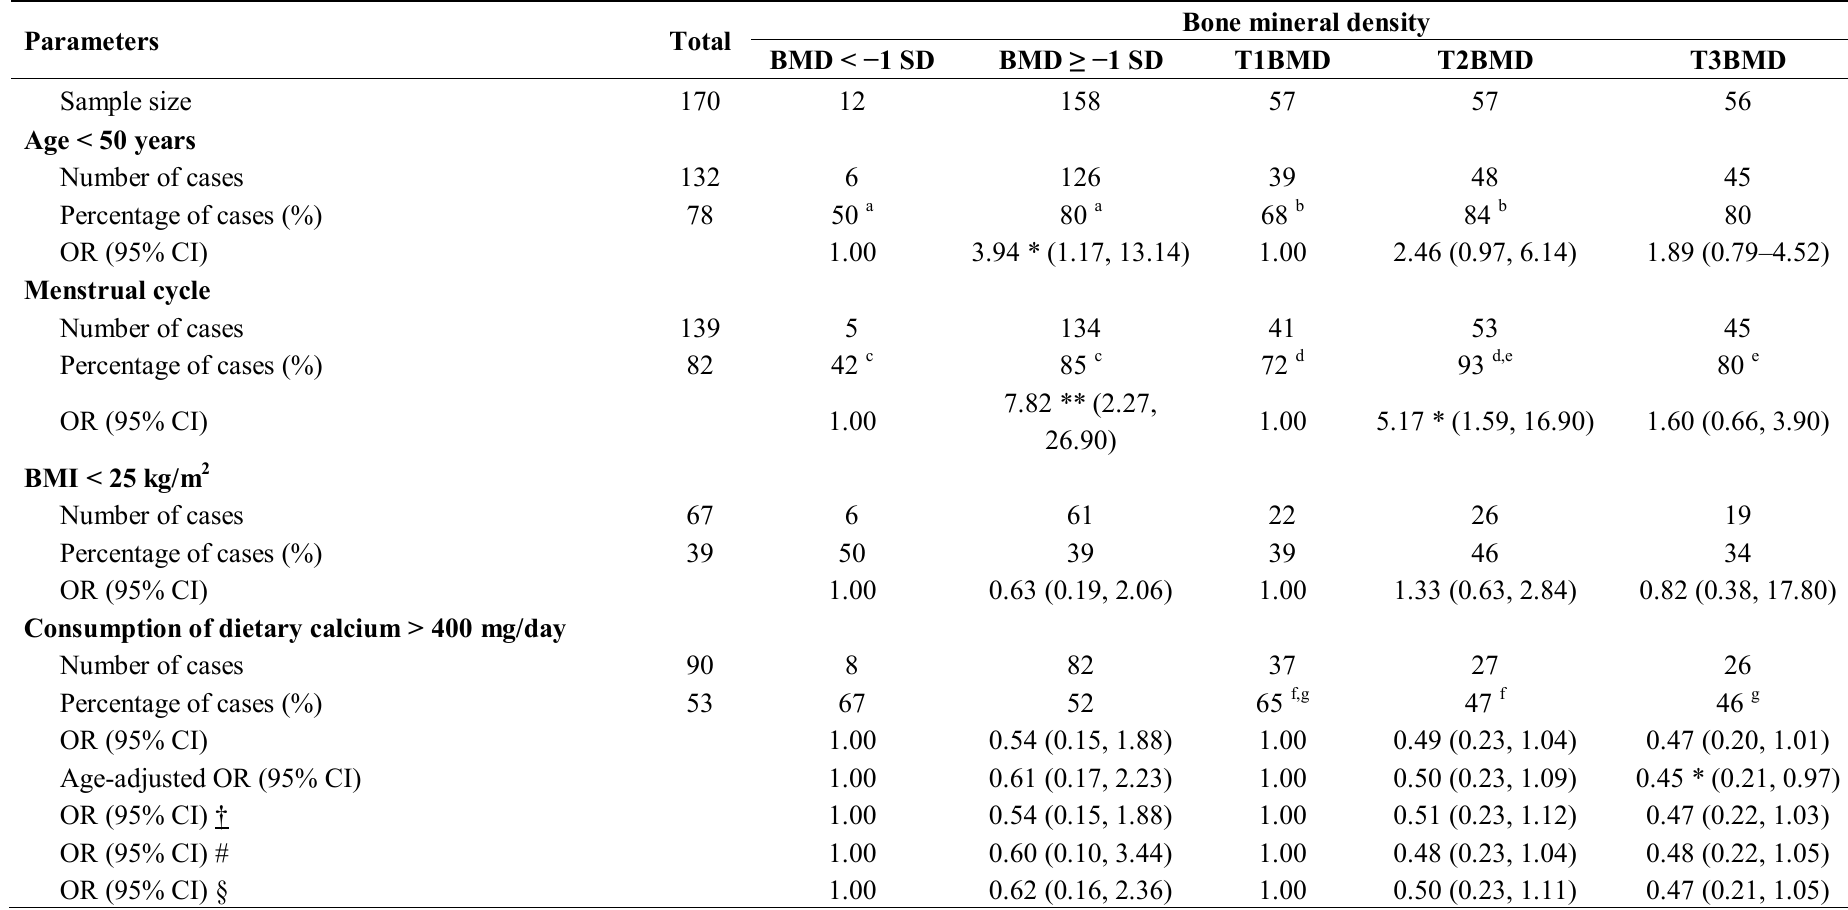
Table 4. Distribution of the sample and the odds ratio (OR) for risk factors for osteoporosis in bone mineral density (BMD) women groups.